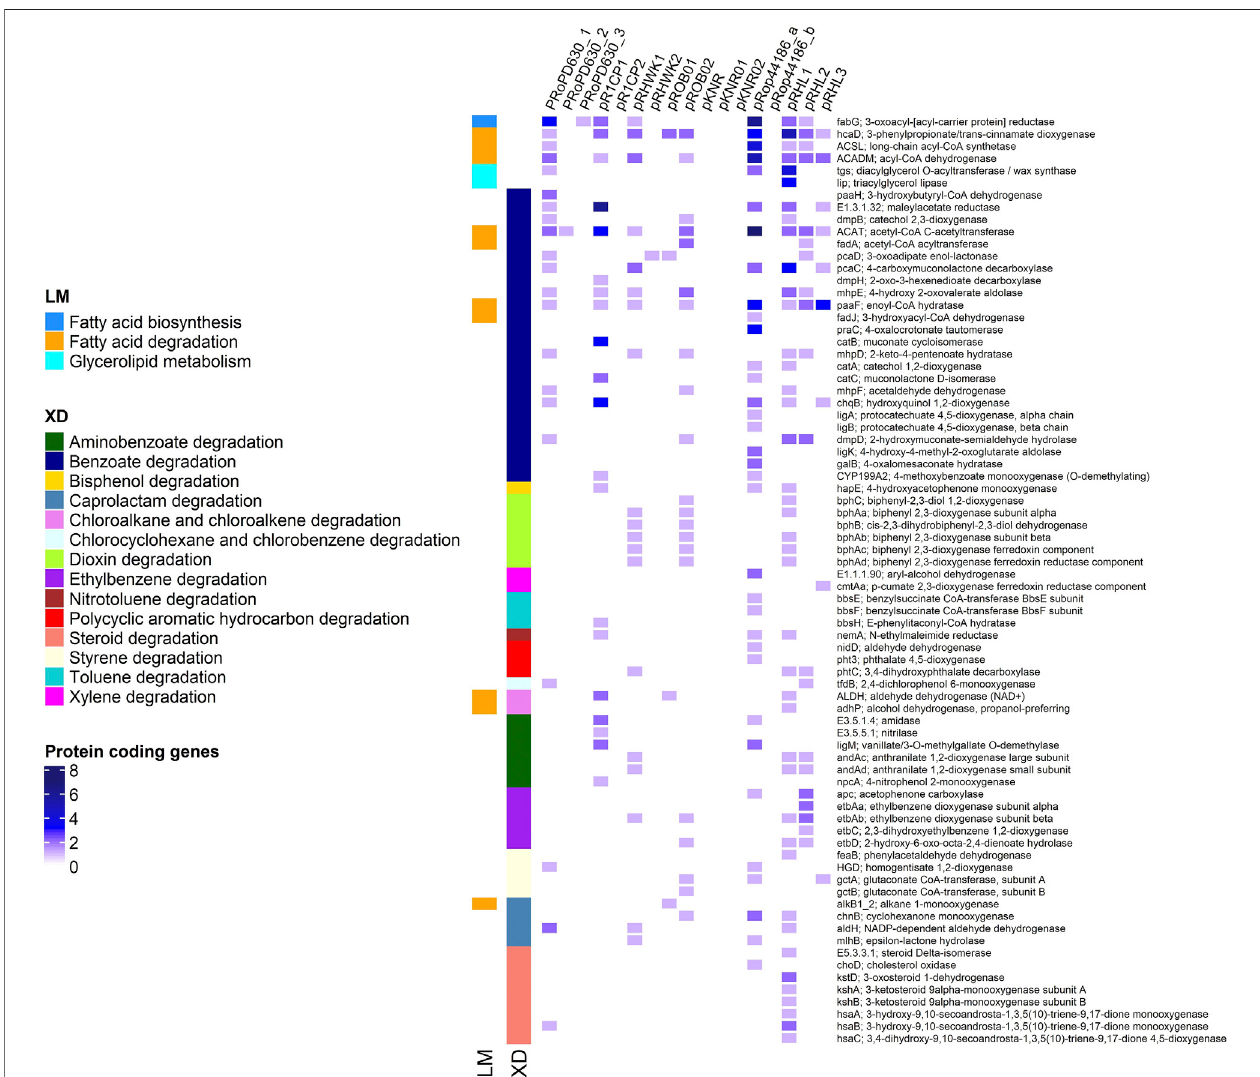
FIGURE2| Functionalpro fi lingoftheprotein codinggenesinvolvedinxenobioticdegradation(XD)andlipidmetabolism(LM)inplasmidsof R.opacus speciesand R. jostii RHA1 (pRHL). The Rhodococcus opacus strains analyzed in this study were R. opacus PD630 (pRoPD630), R. opacus 1CP (pR1CP), R. opacus KT112-7 (pRHWK), R. opacus B4 (pROB and pKNR), and R. opacus DSM 44186 (pRop44186).